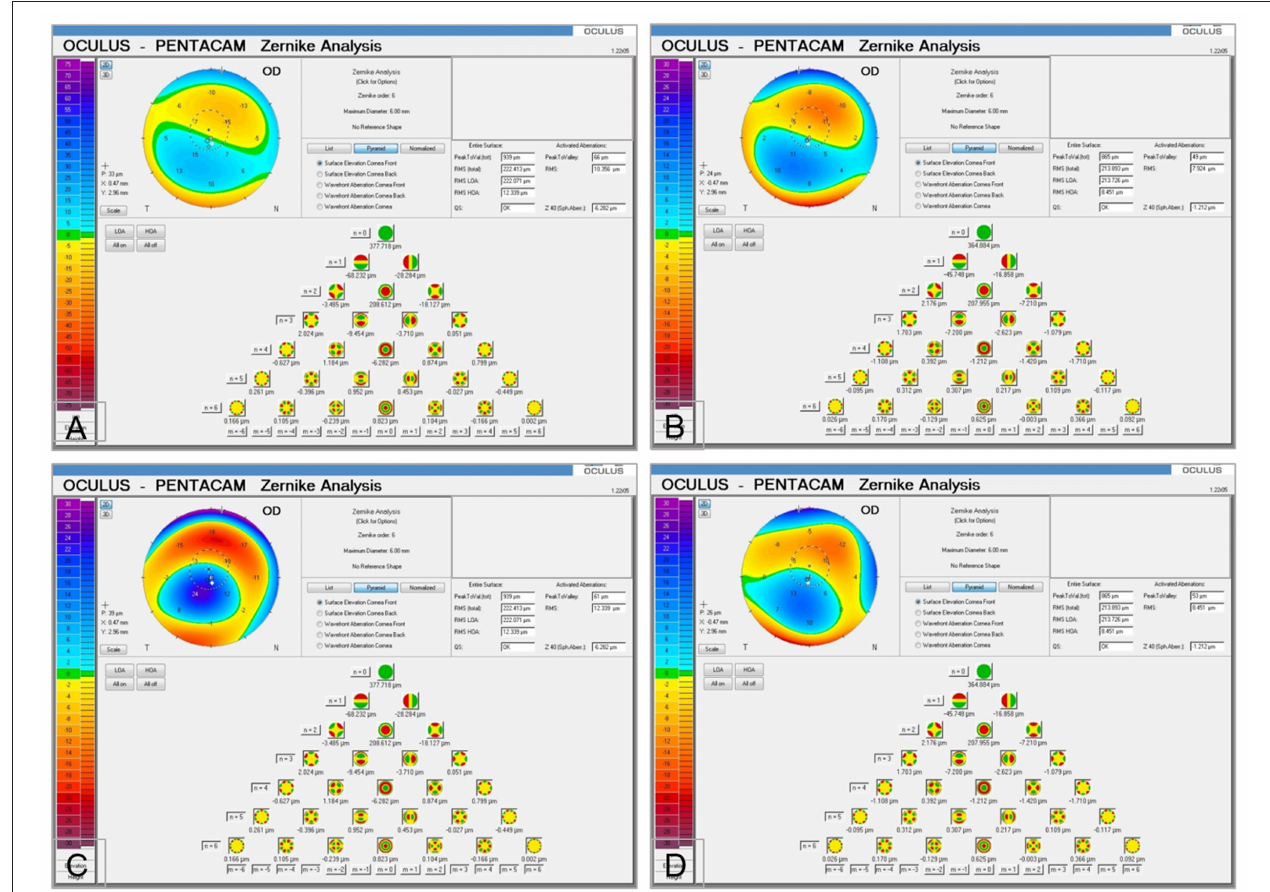
FIGURE 5 | Corneal Aberrometry with case 5, G-2. (A,B) (Pentacam) Third-order aberration RMS 3rd order RMS ( µ m). Observe the improvement in mean values from the preoperative (10.356) ( µ m) till (7.924) ( µ m) at 36 months post-op. (C,D) (Pentacam) high order aberration RMS HOA RMS ( µ m). Notice the amelioration between the preoperative mean values (12.339) ( µ m) and 36 months post-op (8.451) ( µ